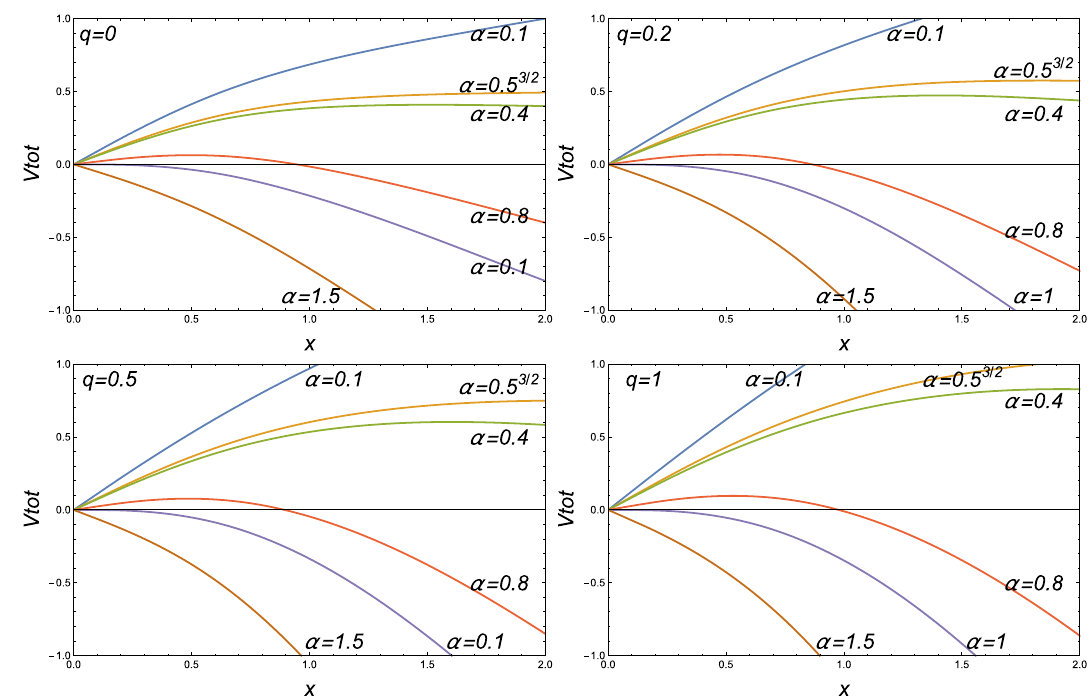
Fig. 4 The dependence on x of the total potential V tot ( x ) with various instanton densities and electric fields (determined by α ) in the confining D0–D4 background. In all graphs we have set b = 0 . 5 and 2 L 3 / 2 / r 1